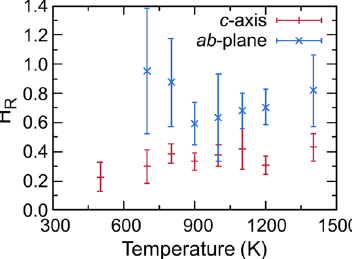
Fig. 5 Haven ratio H R = σ dilute / σ NEMD of LGPS along c -axis and in ab -plane as a function of temperature, respectively. The values and error bars indicate the average and standard deviation of the fi ve independent samples with different initial velocities,